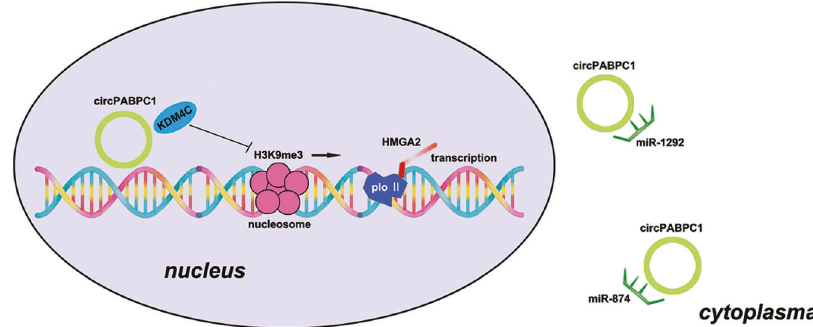
Fig. 8 Mechanism for the regulatory function of circPABPC1 regulates HMGA2 and BMP4/ADAM19 in CRC